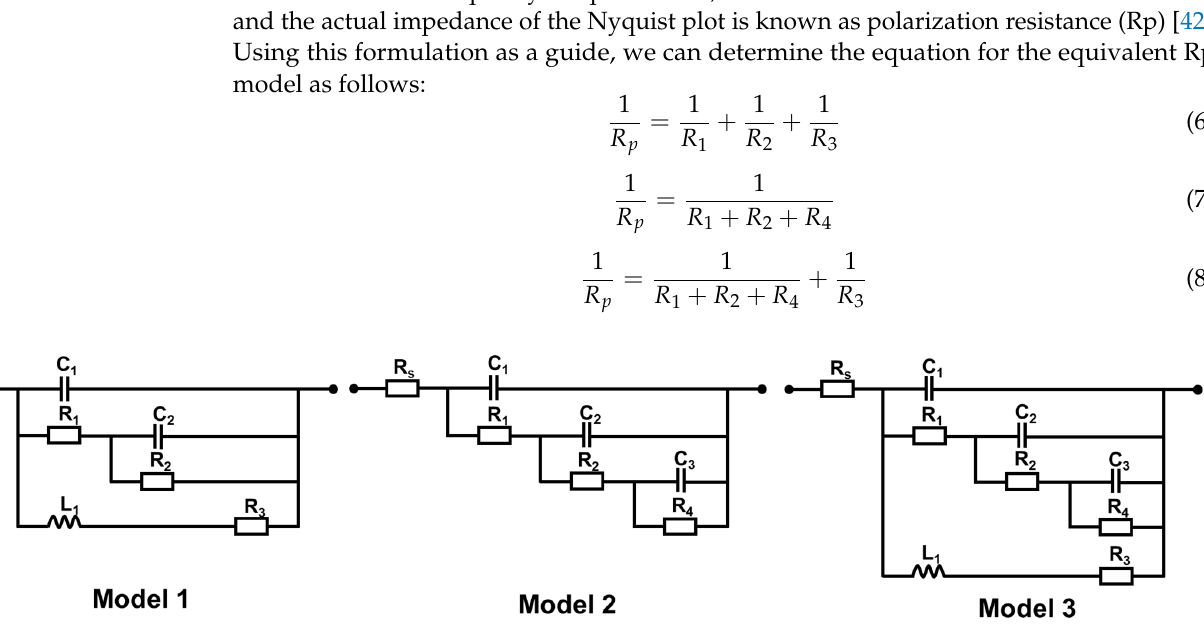
Figure 6. Three equivalent circuit diagrams. Table 1. Electrical parameters for different coating systems immersed in a 3.5% NaCl solution; the values were obtained by fitting the EIS